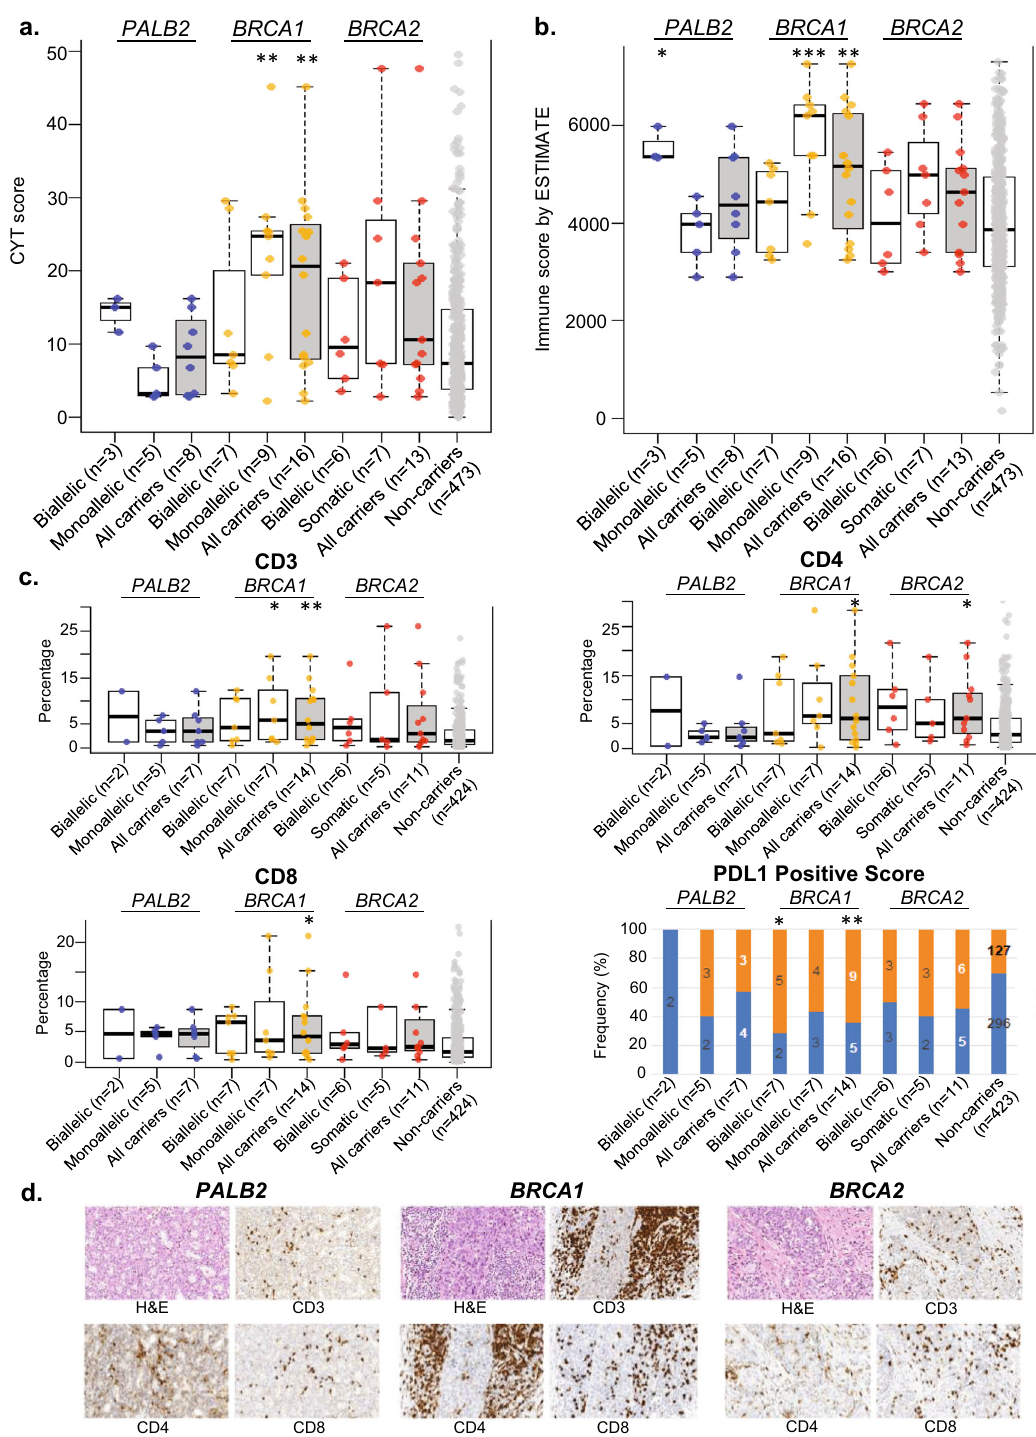
Fig. 5 Comparison of immune pro fi les of tumours (with integrated germline and somatic alterations) that arise from mutation carriers of PALB2 , BRCA1 and BRCA2 and non-carriers. a Cytolytic index (CYT), as measure of CD8 + T cell cytotoxicity. b ESTIMATE score, as measure of lymphocytic in fi ltration. c Distribution of TILs and PD-L1 expression. Only samples with IHC images for analysis were included in this analysis. d Representative images of H&E and IHC for CD3, CD4 and CD8 where image analysis was performed. Boxplots represent medians (centre line) and interquartile range, and whiskers represent the maximum and minimum values within 1.5 times the interquartile range from the edge of the box. Each data point represents an individual sample. P values: Comparison of each category vs non-carrier. ** p < 0.01; * p < 0.05; Mann – Whitney U test (CD3, CD4 and CD8); Chi-square test (PD-L1 positive